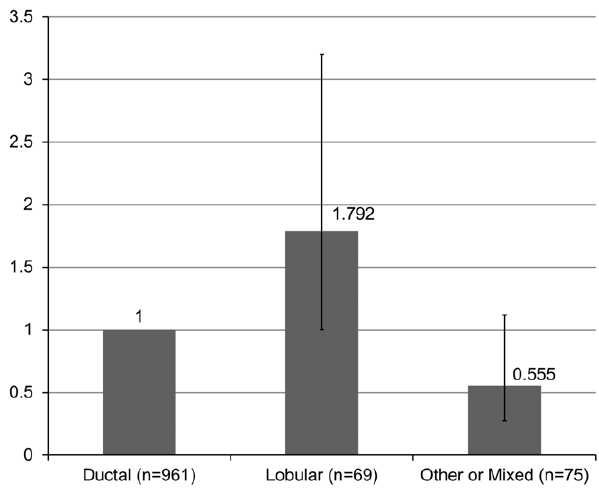
Figure 1. EBV DNA prevalence in specific types of breast carcinoma. Sixteen studies were selected and analyzed for the prevalence of EBV infection [2–4,6,7,9–11,22,25,26,29,30,33–35]. The EBV prevalence rate by type of breast carcinoma is as follows: ductal (28.60%), lobular (34.78%) and other or mixed types (17.33%). Lobular carcinoma showed a significantly higher EBV prevalence than ductal carcinoma (adjusted OR=1.792, 95% CI=1.003–3.200, OR was adjusted by region, publication calendar period and specimen type), indicating that EBV infection probably increases breast carcinoma risk, especially for some specific types of carcinoma such as lobular carcinoma,